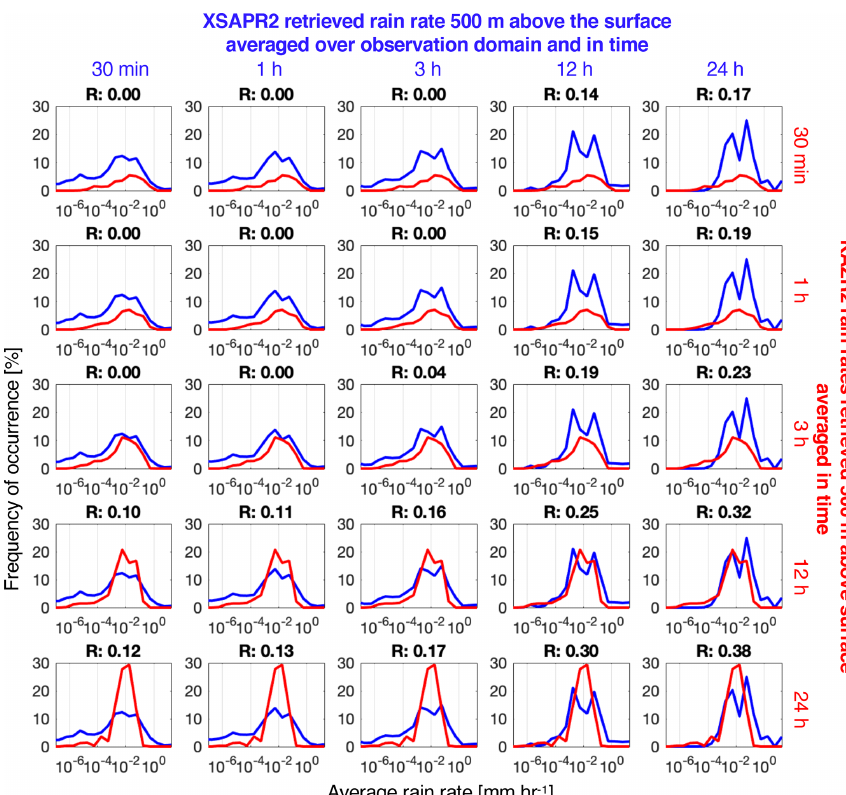
Figure 10. Probability density function of average (over different time windows) precipitation rate as estimated the XSAPR2 and by the KAZR2 (red), both at 500m above the surface in 10 0 . 5 mmh − 1 bins. The XSAPR2 precipitation rates 500m above the surface being from gridded CAPPI constructed using a collection of PPI scans and limited to the domain between 2.5 and 40km around the location of the KAZR2. Over each box is the correlation coefficient ( R ) between the XSAPR2 and the KAZR2 average precipitation